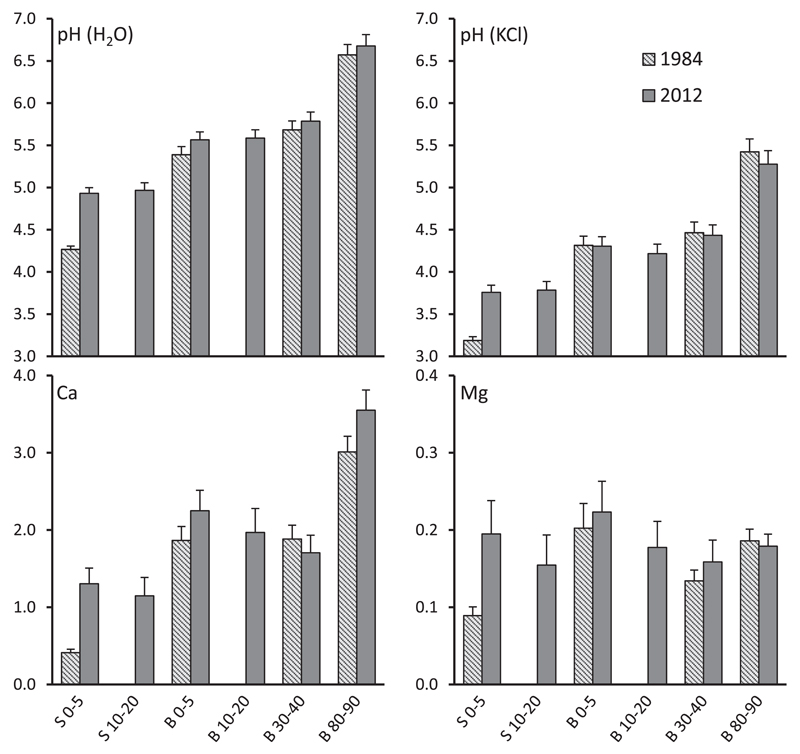
Mean soil pH (in H2O and KCl) and soil contents of Caexch and Mgexch (mg g−1) in different soil depths of the stemflow area (S 0–5 and S 10–20) and the between trees area (B 0–5, B 10–20, B 30–40 and B 80–90) at 97 beech stands in 1984 and 2012. Error bars are ± S.E.